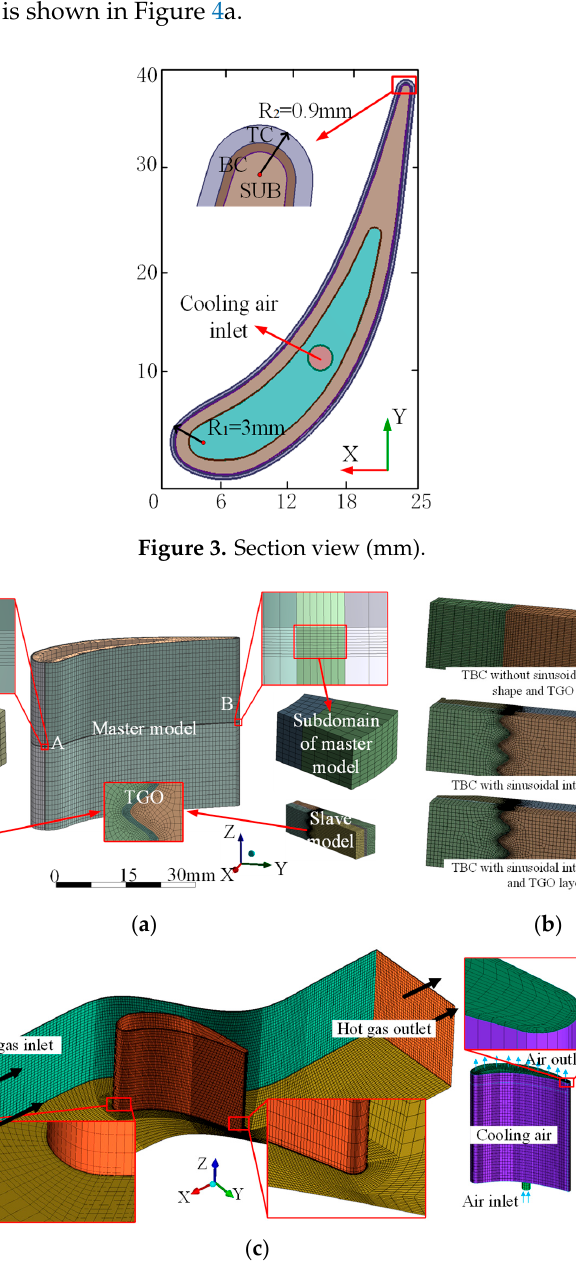
Figure 4. Meshing of the NGV and master–slave models. ( a ) Master–slave model; ( b ) Typical slave models; ( c ) Flow domain.